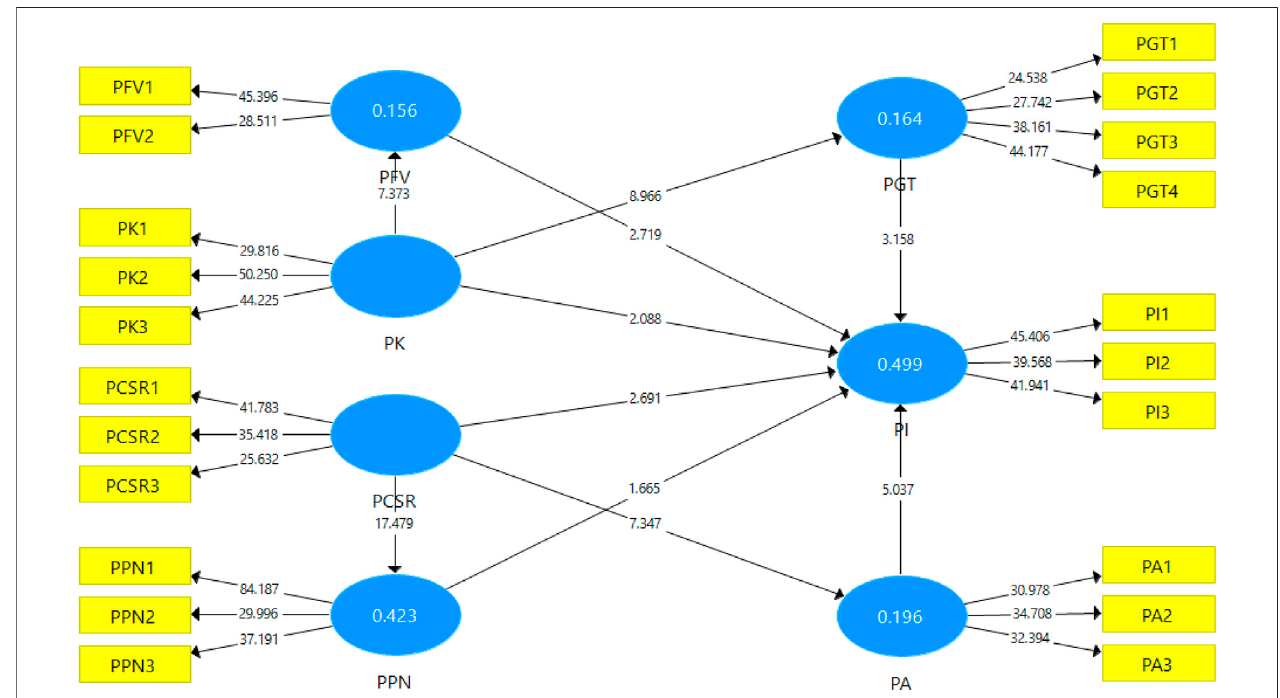
FIGURE 3 | Structural